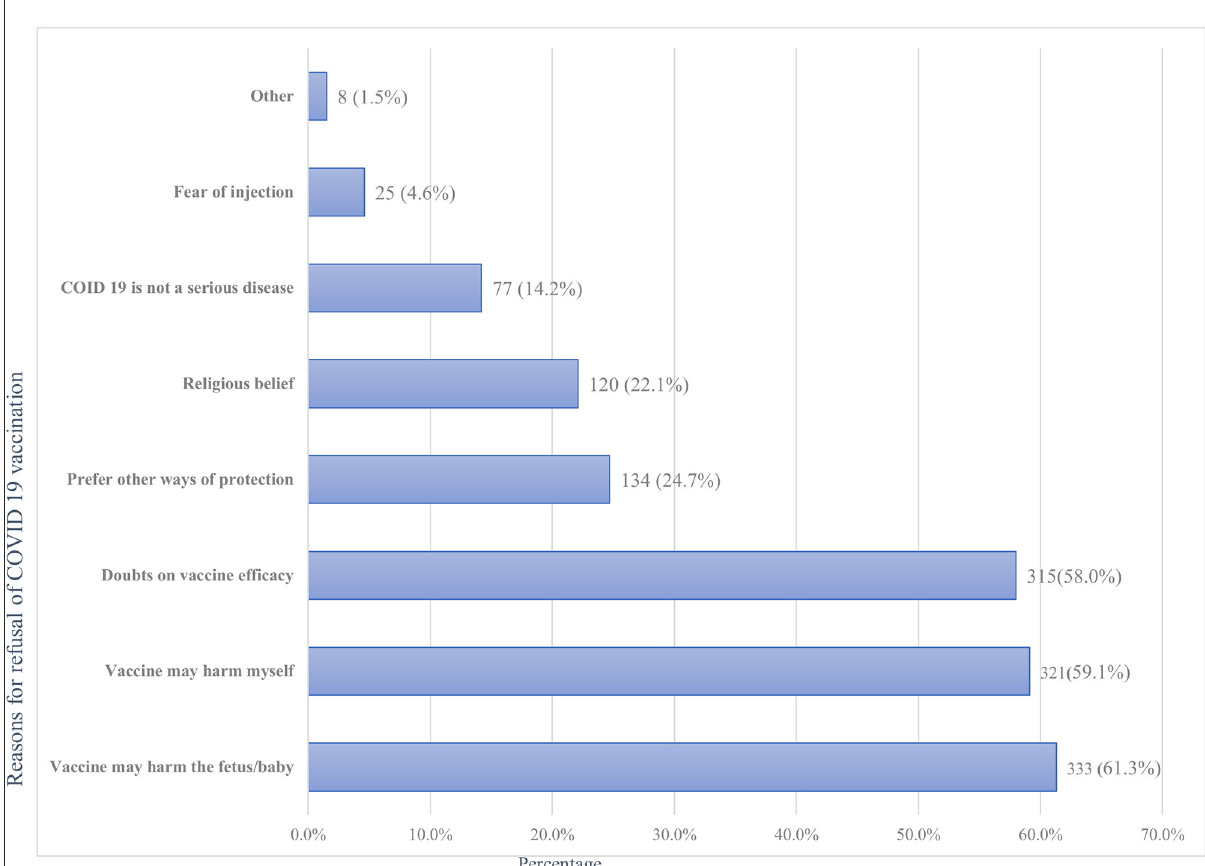
FIGURE3 Reasons for refusal of the COVID-19 vaccination among pregnant women attending antenatal care in Debre Tabor public health institutions, Northwest Ethiopia, 2022.